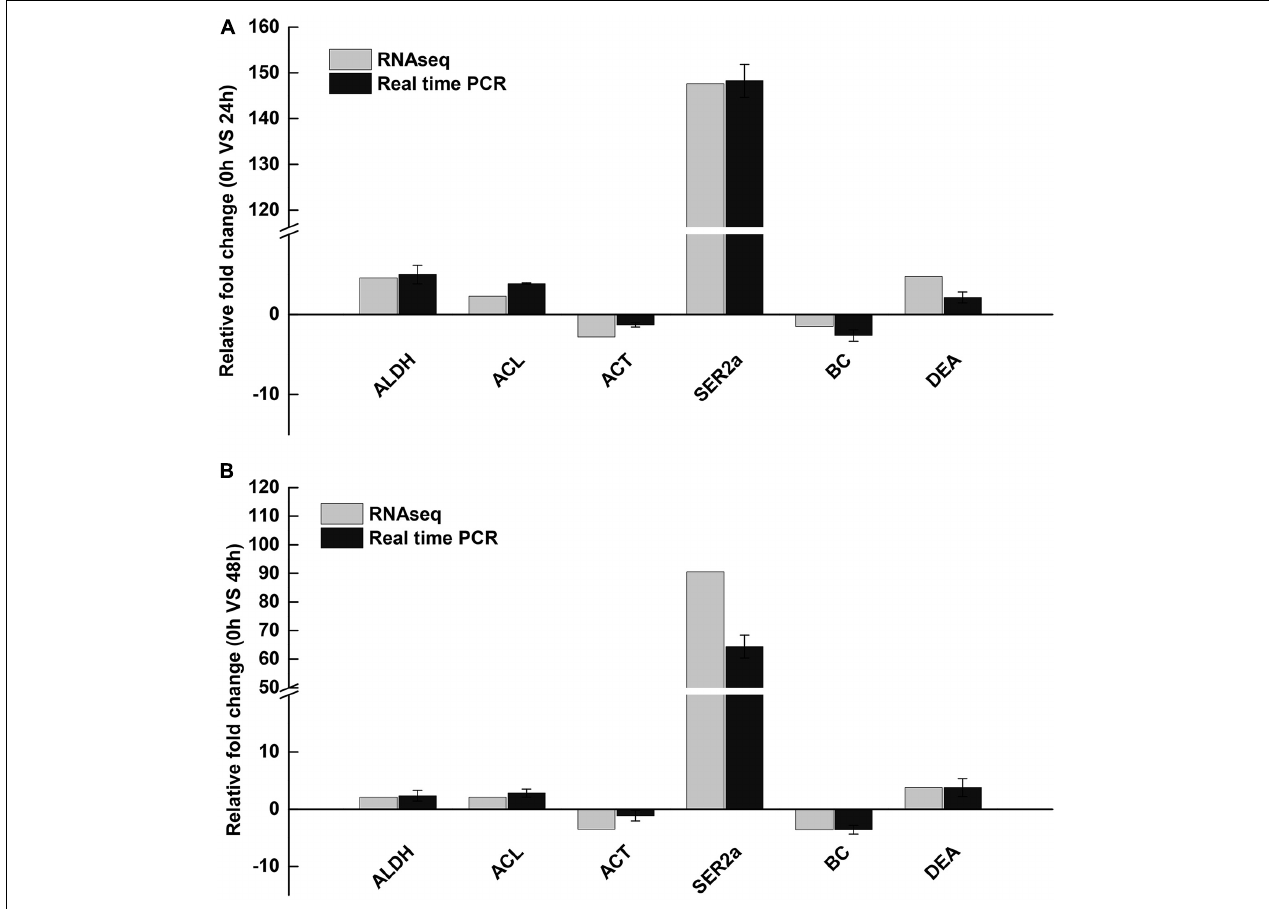
FIGURE 6 | Validation of RNA-Seq results using qRT-PCR. (A) 24 h saline-alkali stress, (B) 48 h saline-alkali stress. ALDH, acetaldehyde dehydrogenase; ACL, ATP citrate lyase; ACT, actin; SER2a, sarcoplasmic reticulum Ca 2 + -ATPase; BC, blood coagulating protein; DEA,